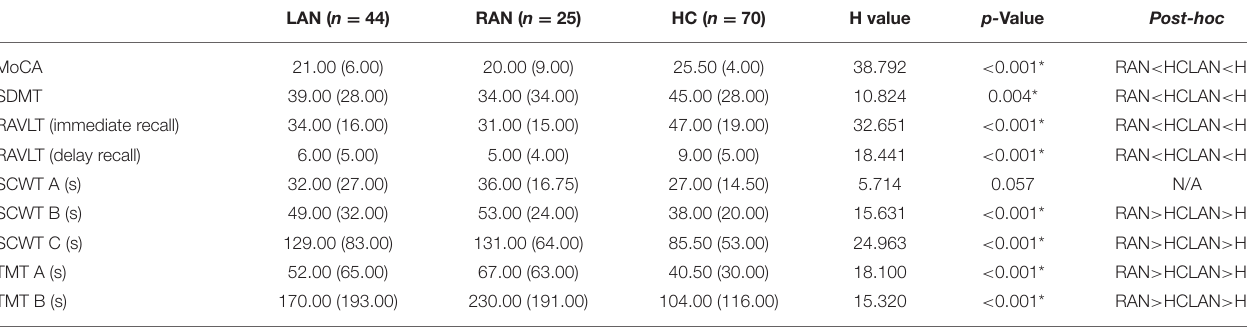
TABLE 1 | Comparison of clinical data and cognitive function among LAN, RAN, and HC groups.